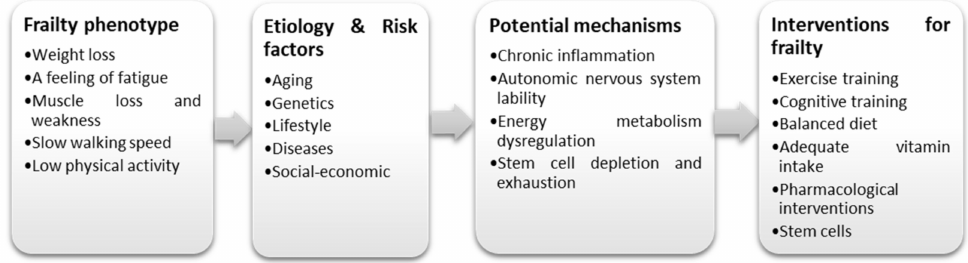
Figure 1. Etiology/risk factors, potential mechanism, frailty phenotype and interventions for